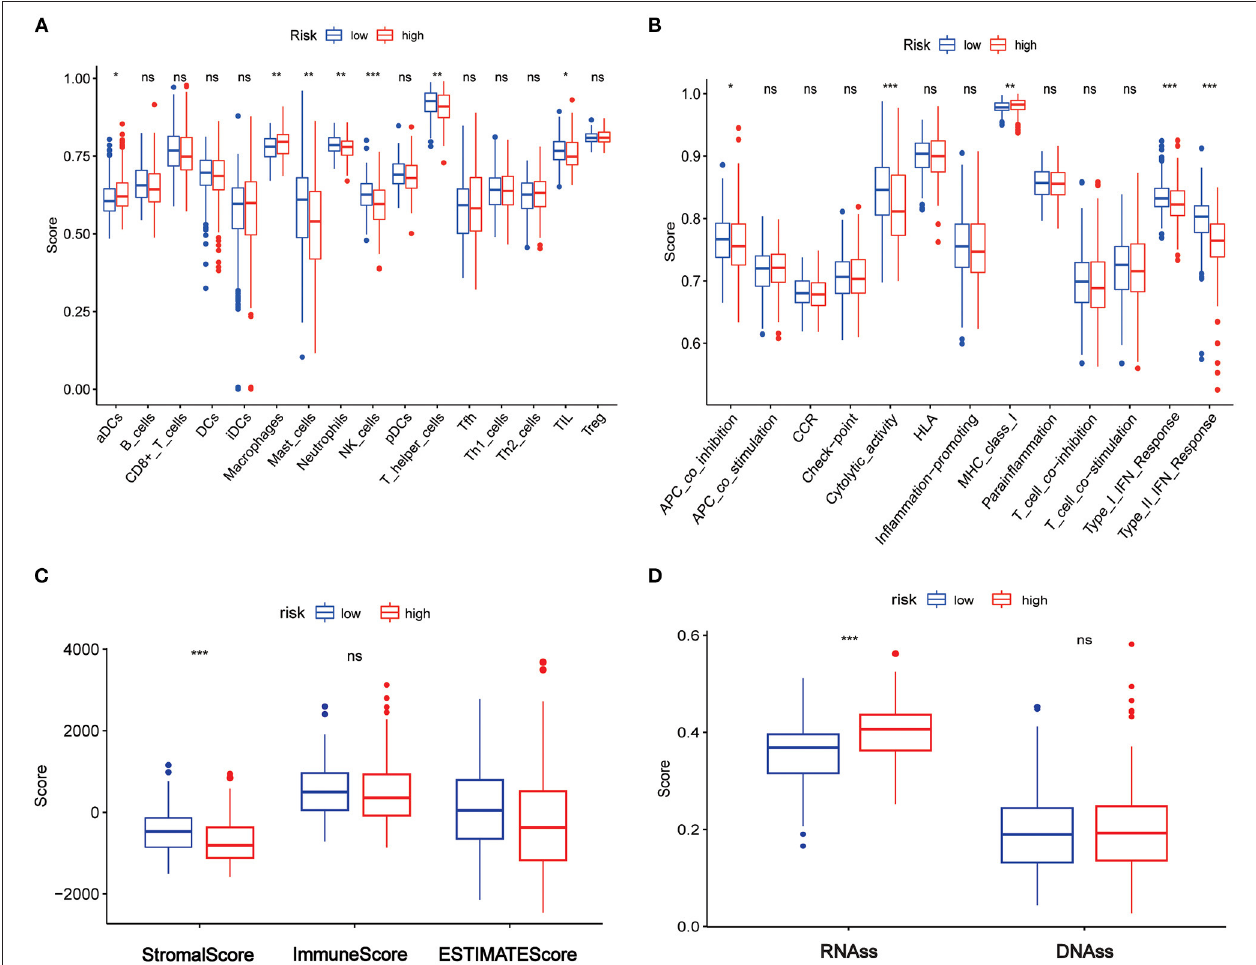
FIGURE 8 | Association between the risk score and tumor immune, tumor microenvironment, and tumor stemness in TCGA set. (A) The ssGSEA scores of immune cells. (B) The ssGSEA scores of immune-related functions. (C) Association of risk score and tumor microenvironment. (D) Association of the risk score with RNAss and DNAss. Adjusted p -values are shown as ns, not significant; * p < 0.05; ** p < 0.01; *** p < 0.001.